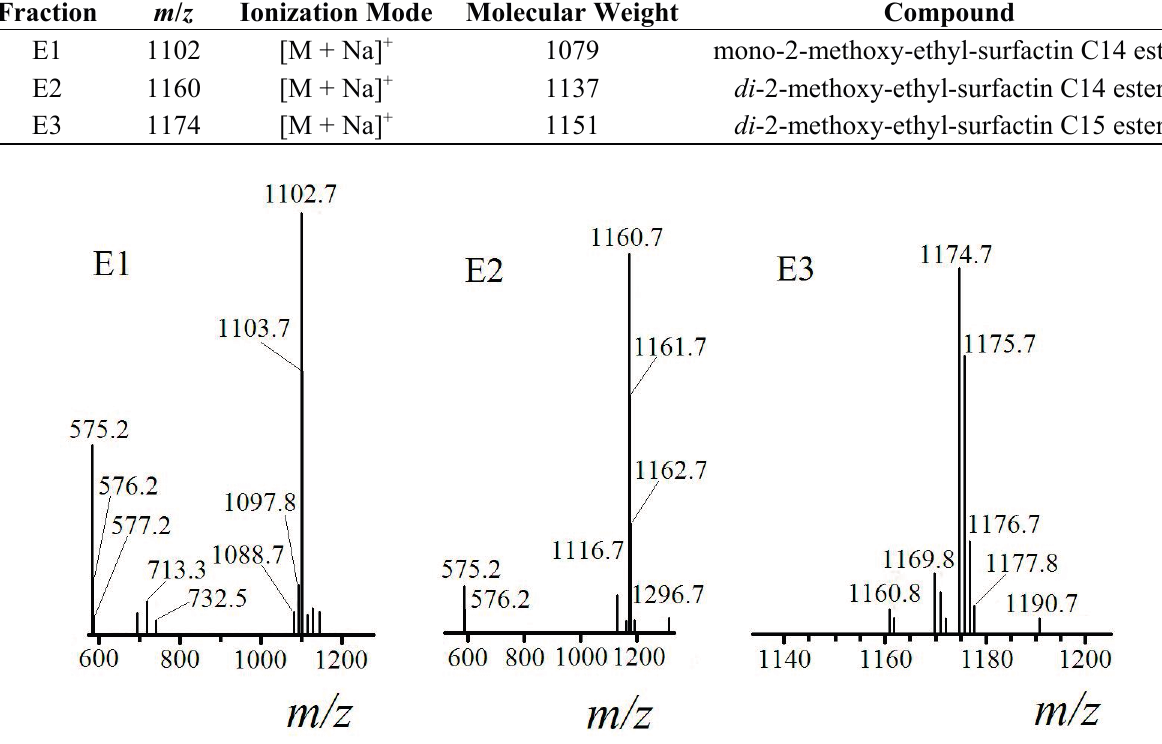
Figure 8. ESI-MS spectroscopy of E1, E2 and E3.